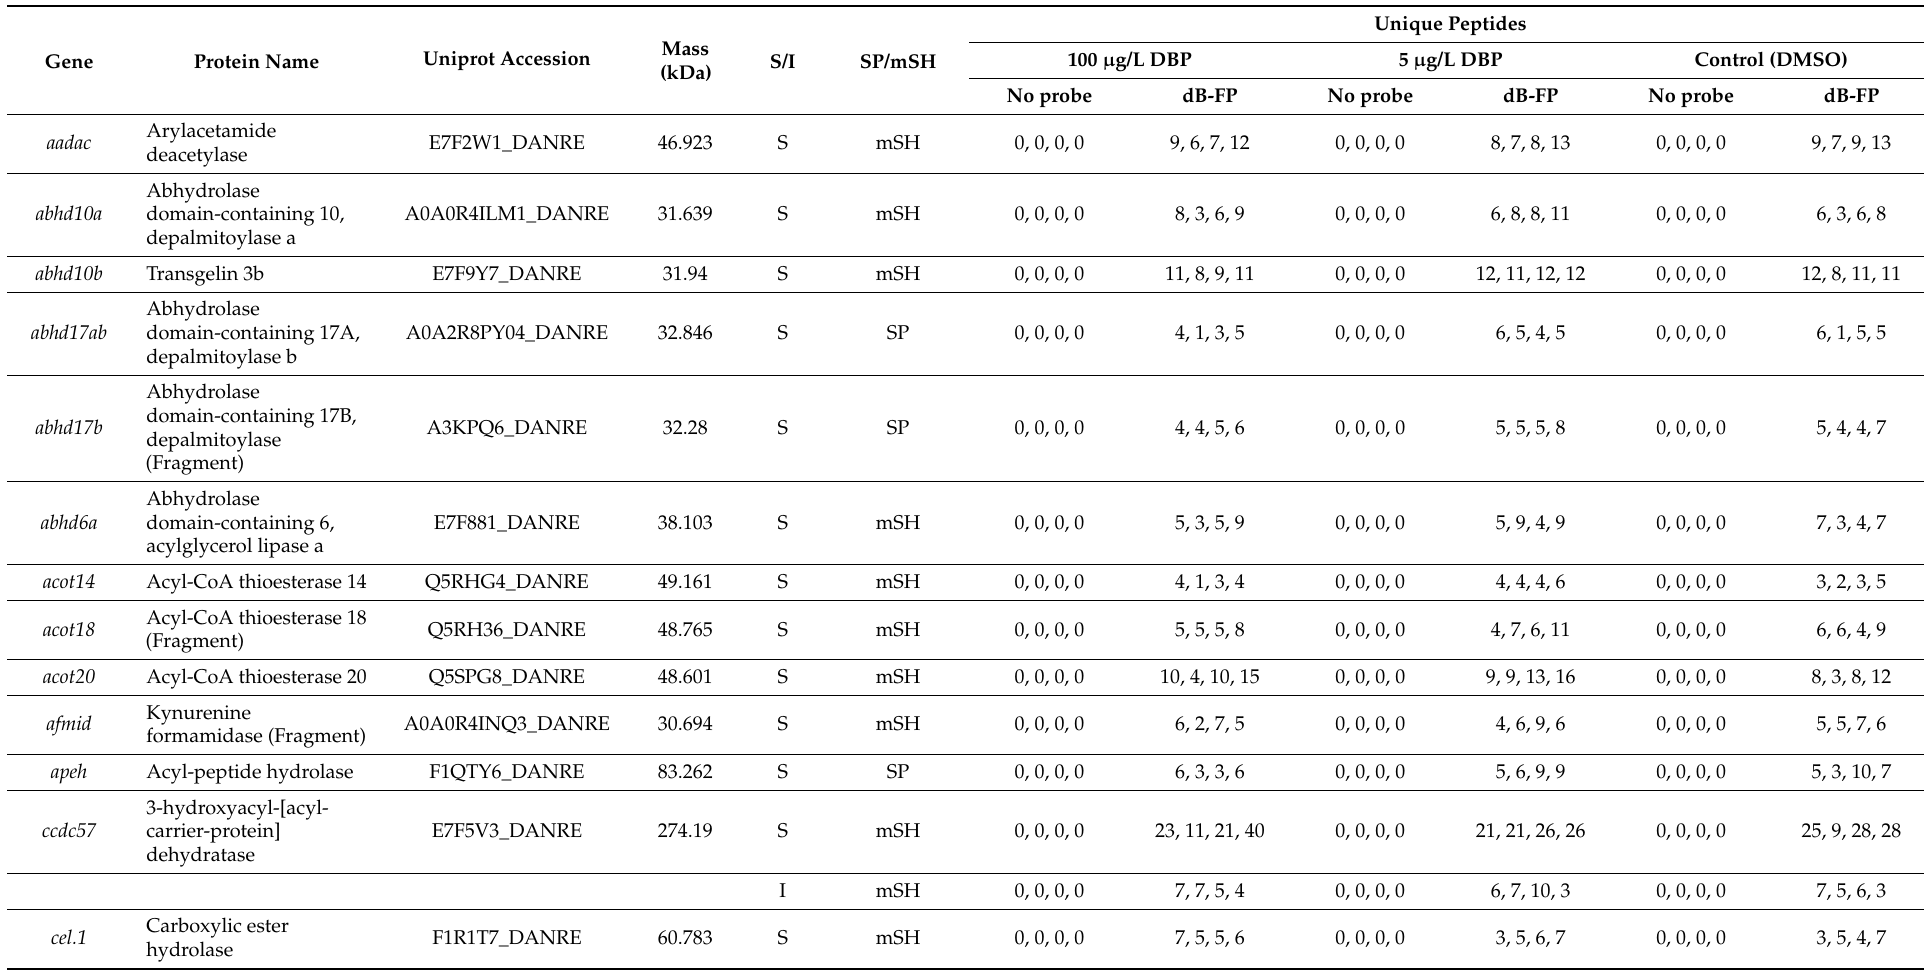
Table 1. Danio rerio proteins enriched by dB-FP affinity purification. For each protein identified we have the following information: name of the gene, name of the protein, Uniprot accession, mass (kDa), fraction in which it was identified (S for soluble and I for insoluble), type of SH (SP for serine protease and mSH for metabolic serine hydrolase), unique peptides identified in each of the 4 biological replicates and in each sample (100 µ g/L DBP, 5 µ g/L DBP and control). For each sample we have the unique peptides identified without probe (No probe) and those identified in the presence of probe